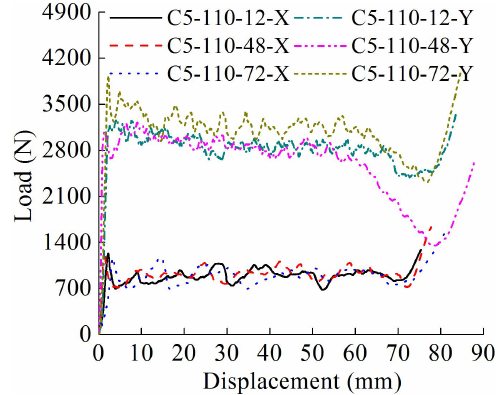
Figure 17: Load and displacement curves of paper corrugation tubes